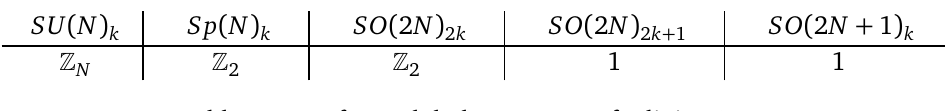
Table 3: One-form global symmetry of adjoint